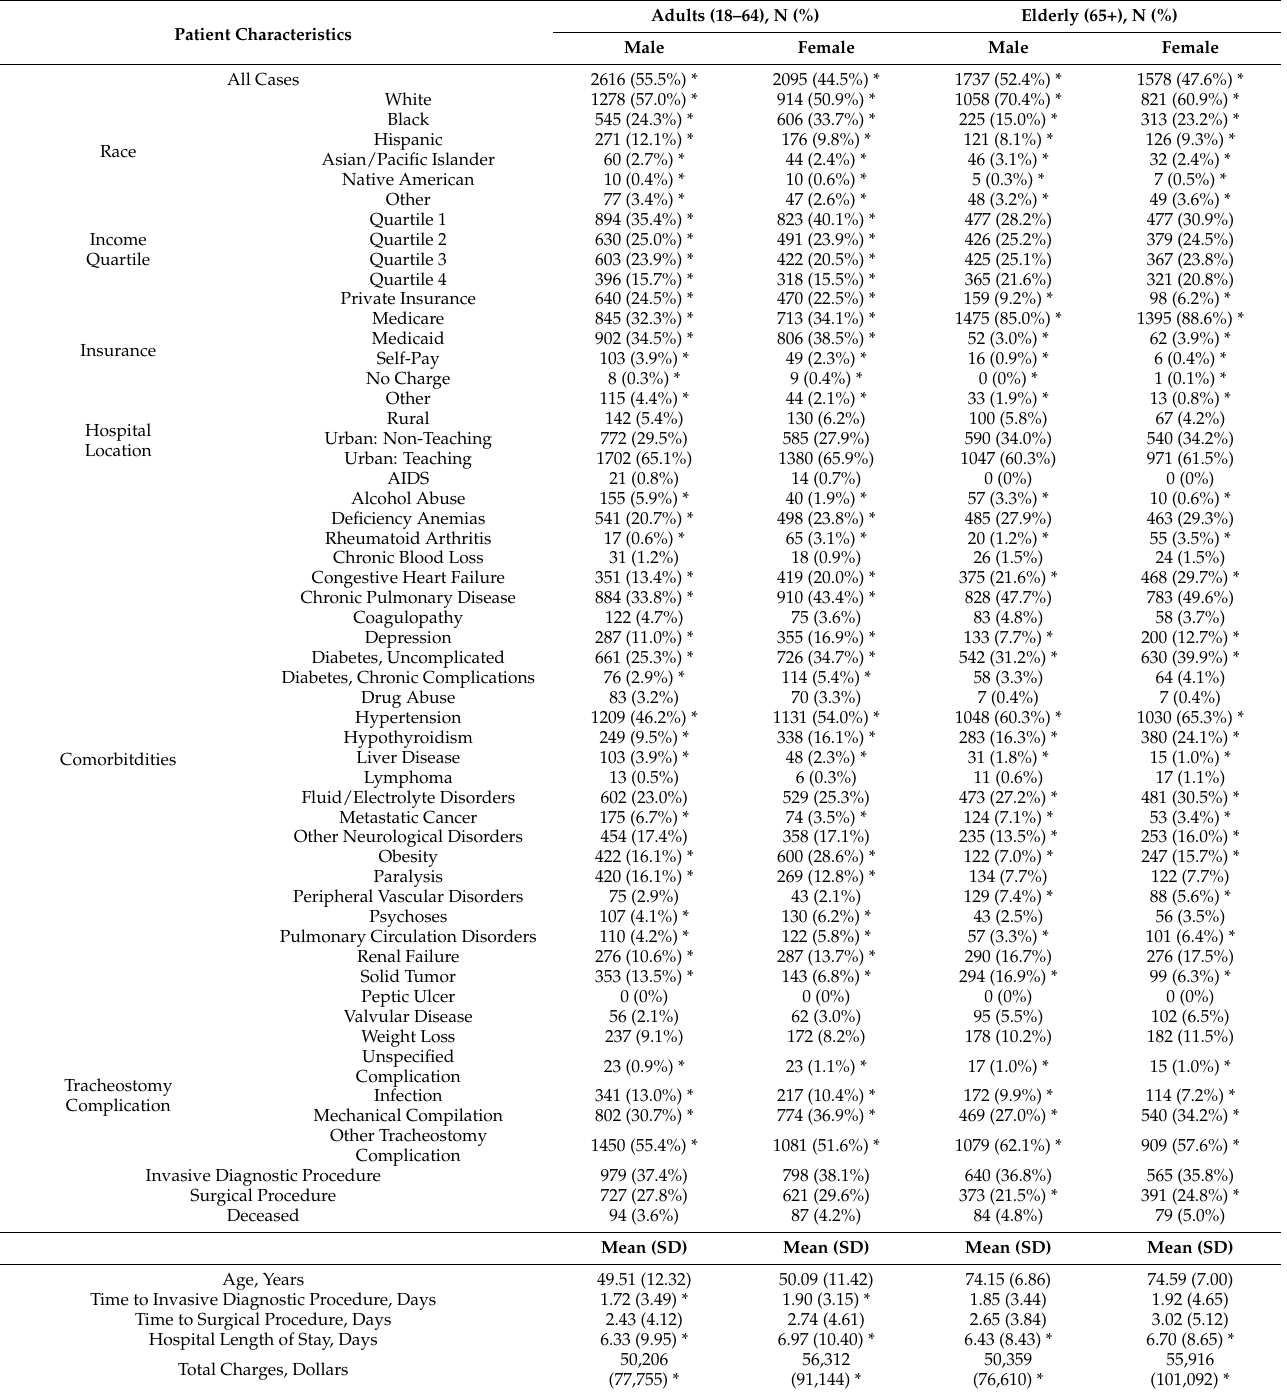
Table 2. Characteristics of emergently admitted patients with the primary diagnosis of tracheostomy complications (NIS 2005–2014). Data were stratified according to gender categories. * p <